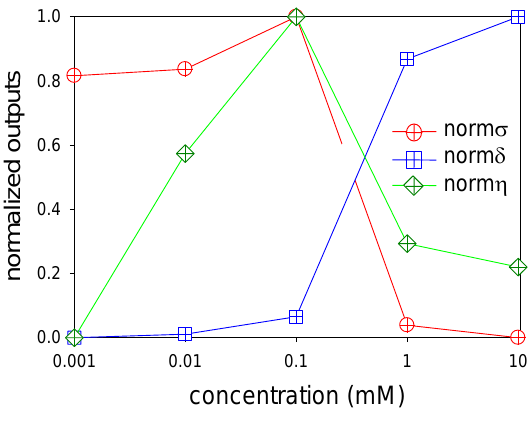
Figure 8. Normalized outputs of AA-PSP. The pressure sensitivity is shown as norm  , the temperature dependency as norm  , and the signal level as norm  , respectively.